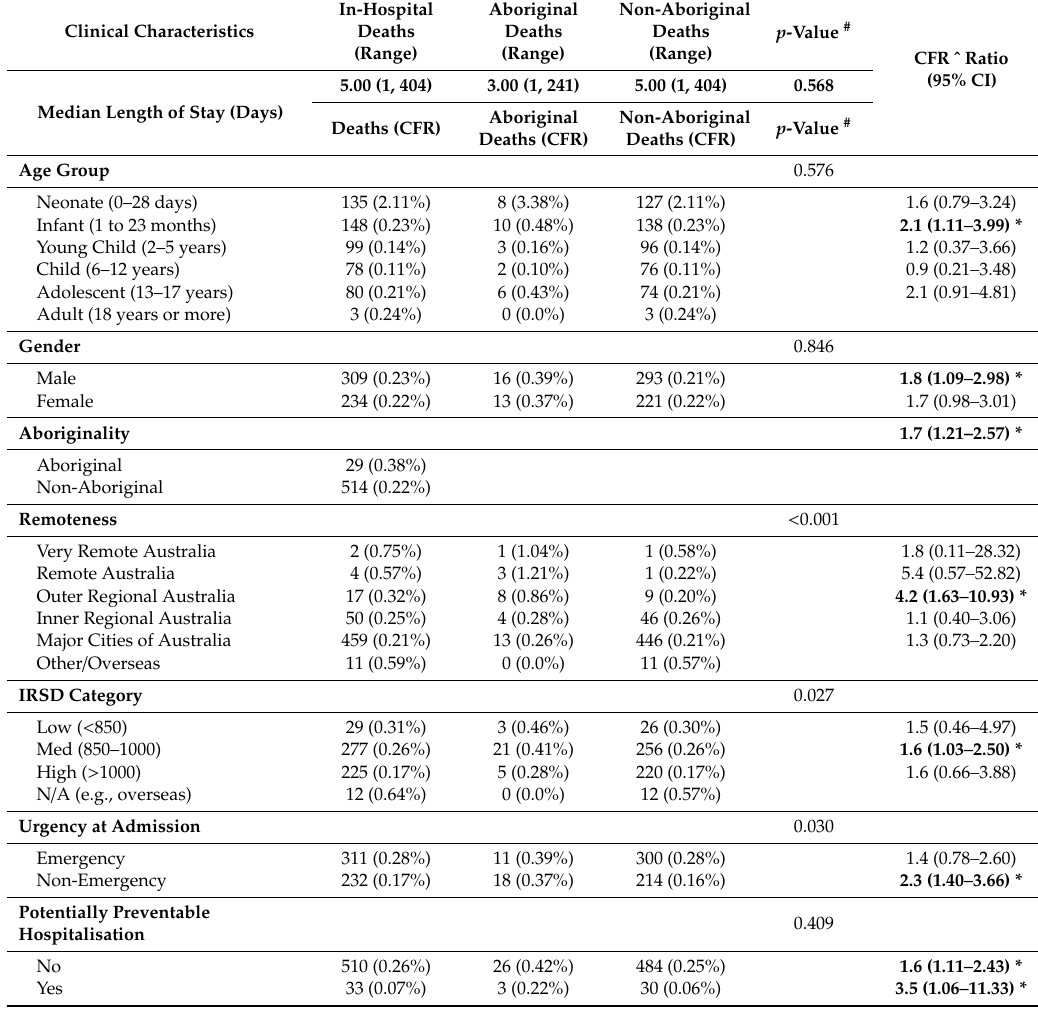
Table 2. Demographic and clinical characteristics of